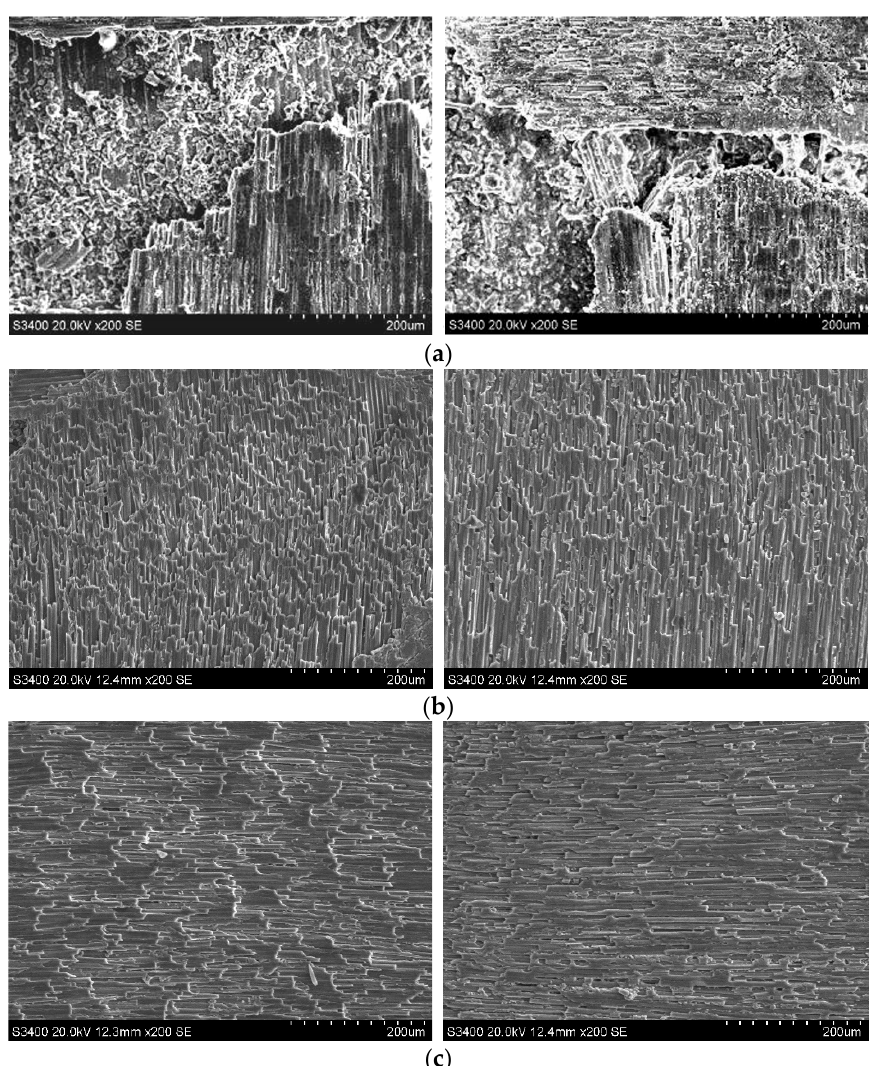
Figure 13. Surface micromorphology of the C/SiC composite material after side face grinding: (left) CG; (right) UAG(v s = 12.6 m/s, v w = 100 mm/min, a p = 0.1 mm). ( a ) Pore micromorphology. ( b ) 0° fibers. ( c ) 90° fibers.